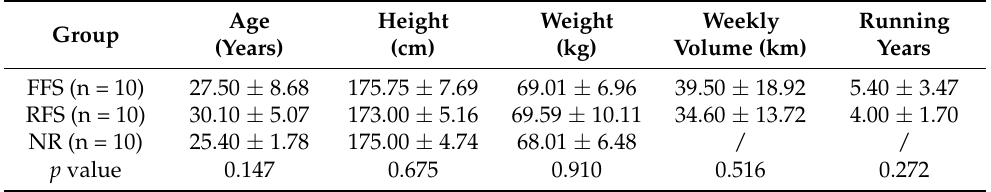
Table 1. Basic information of the